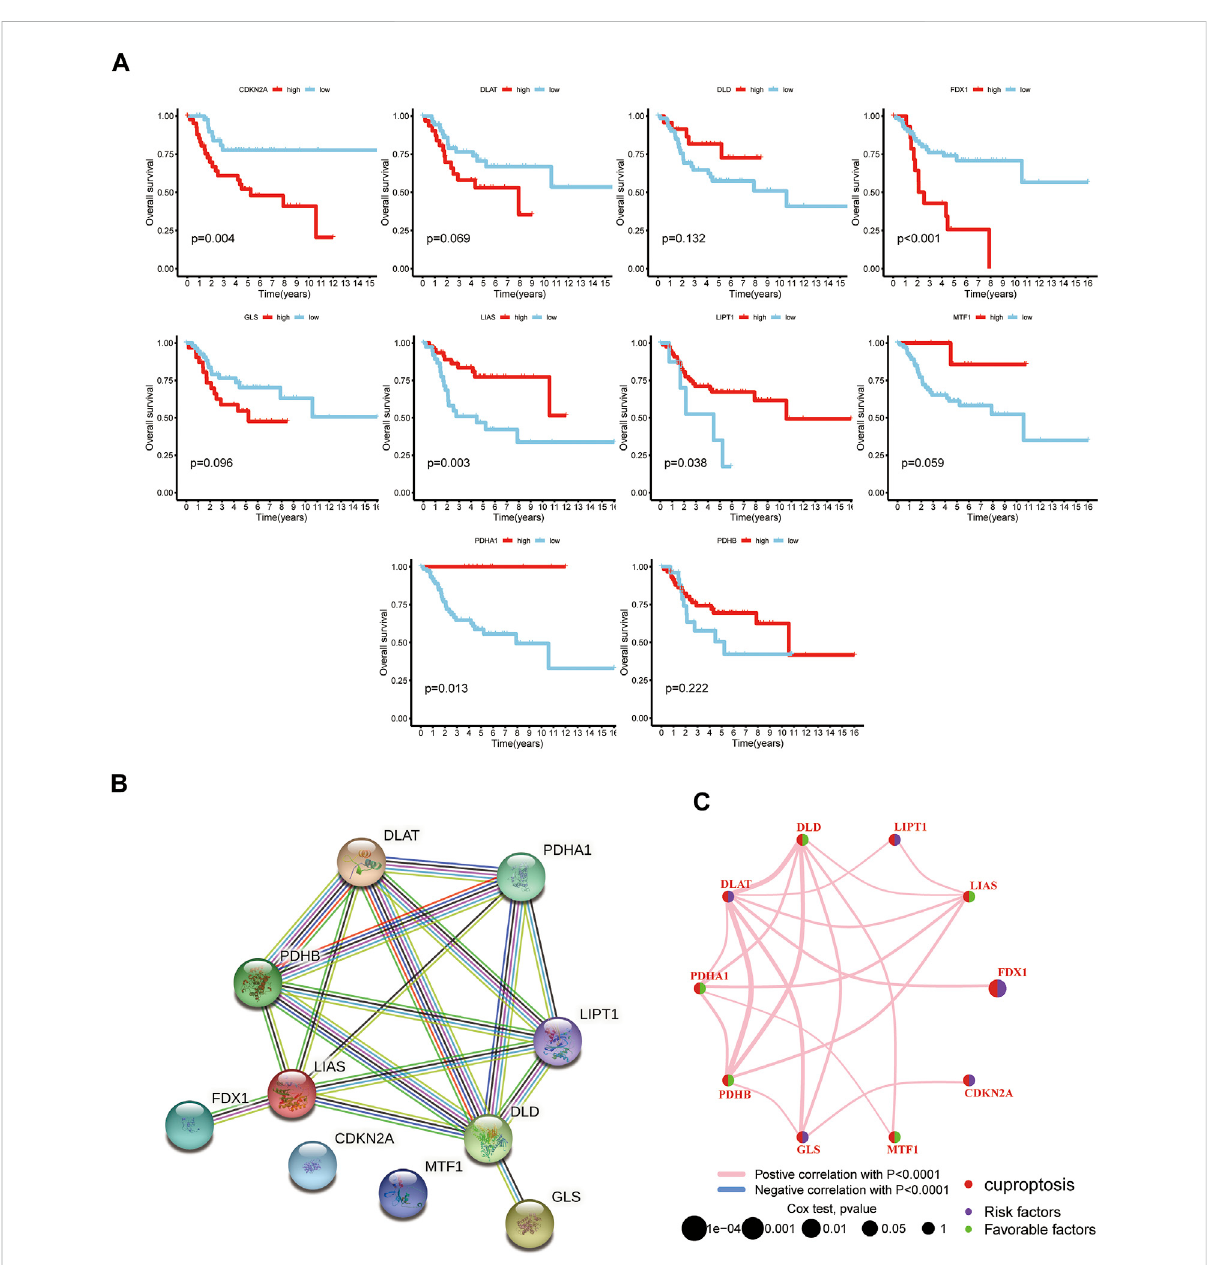
FIGURE 2 Theprognosticvalueof10CUGsinpatientswithOS. (A) Kaplan-Meiercurvesforthe10CUGsinOSpatientsfromTARGETdatabase. (B) ThePPI network acquired from the STRING database among the CUGs. (C) A network of correlations including CUGs in the TARGET cohort. ( p < 0.05 *; p < 0.01 **; p < 0.001